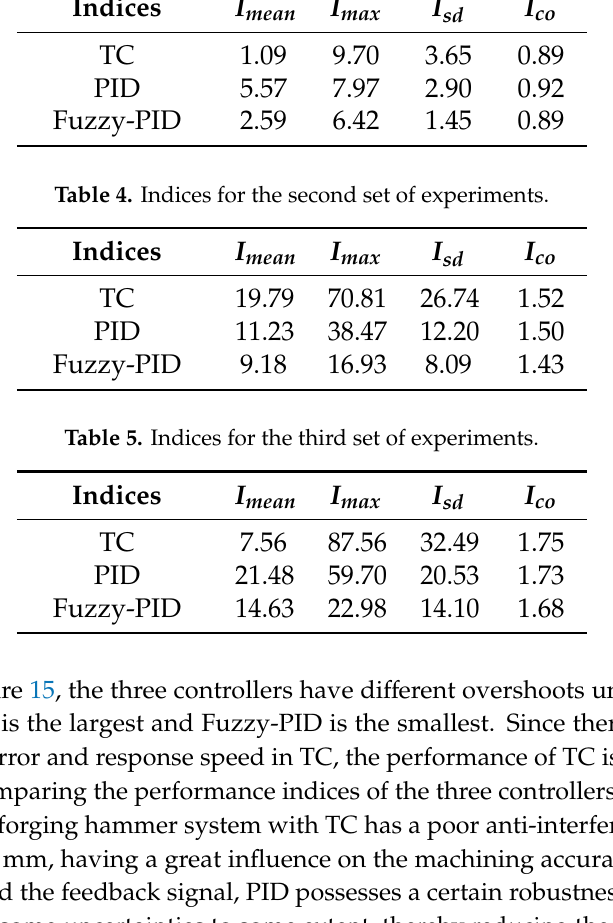
Figure 17. Experiments of fast-level trajectory motions (Fast Forging).